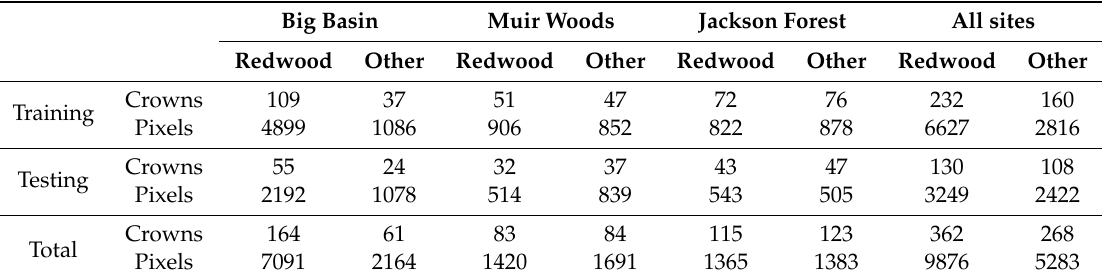
Table 2. Sample sizes for the training and testing datasets for all three sites. Pixel values indicate the sample sizes input during the model development and testing. Values shown are the values following the masking of shaded and low-normalized difference vegetation index (NDVI)